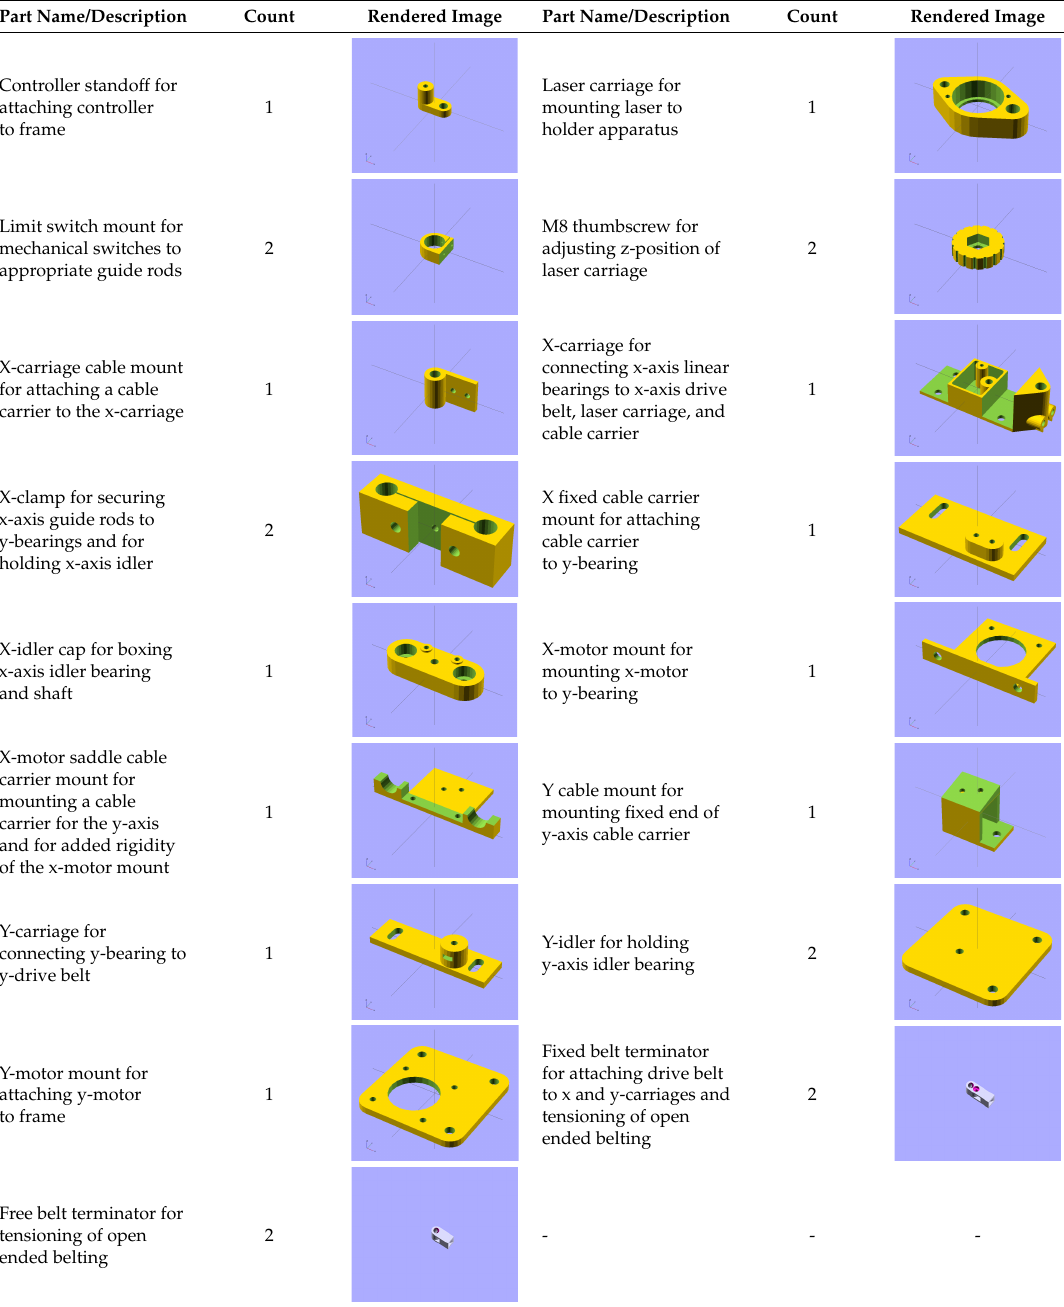
Table 1. Three-dimensional (3-D) printed parts.